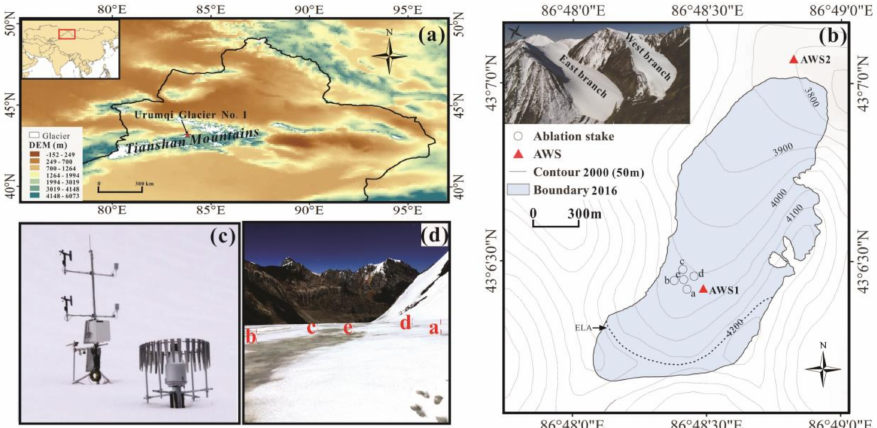
Figure 1. ( a ) Geographical location of Urumqi Glacier No. 1 in the Chinese Tian Shan, central Asia, ( b ) glacier contour map showing locations of the automatic weather stations (AWSs) and the nearby mass balance stakes on the east branch. The glacier boundary was derived from a 3D laser altimetry survey on 1 September 2016 [35]. The photo in the upper left section was taken by an unmanned aerial vehicle at the end of April 2018. The two photos at the bottom-left are ( c ) AWS system and rain gauge, and ( d ) ablation stakes near to